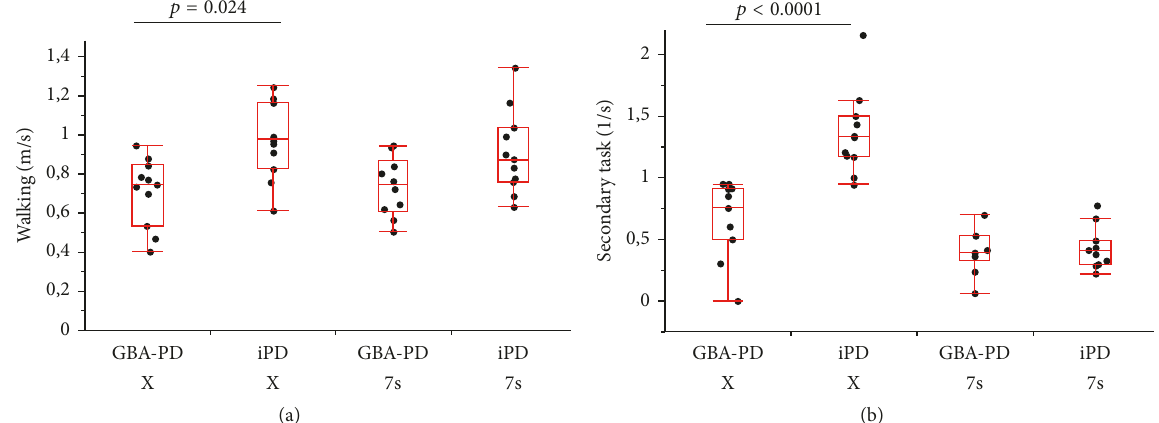
Figure 1: (a) Dual-task performance “walking while checking boxes (X) or while subtracting serial 7s (7s).” (b) Dual-task performance “checking boxes (X) or subtracting serial 7s (7s) while walking.” A logistic regression analysis, with the motor part of the Unified Parkinson’s Disease Rating Scale and the Montreal Cognitive Assessment as covariables, including likelihood ratio was used to calculate 𝑝 values. Significance level was set at 𝑝 < 0.05 . GBA-PD = Parkinson’s disease patients carrying a heterozygous glucocerebrosidase mutation; iPD = idiopathic Parkinson’s